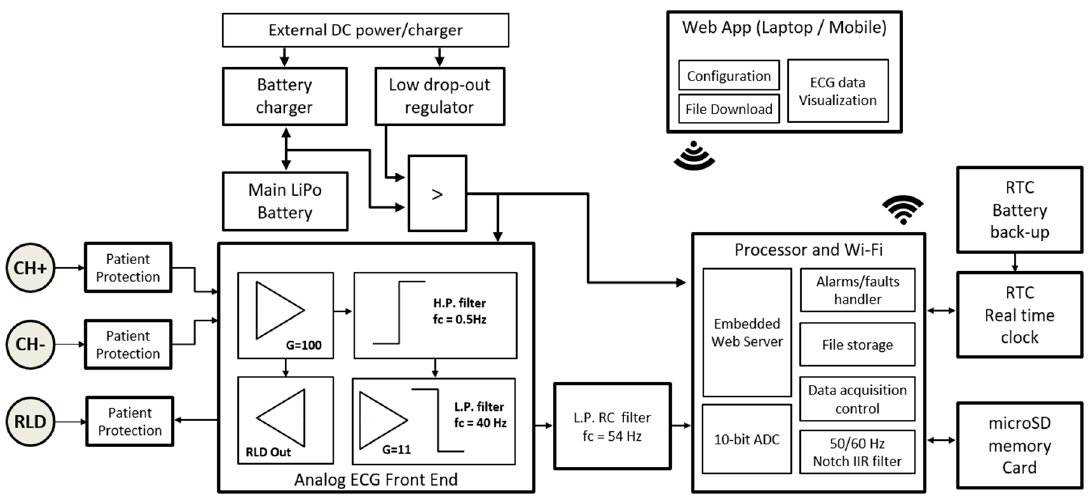
Figure 6. Architecture block diagram of the devised arm-ECG wireless sensor system (WAMECG1).